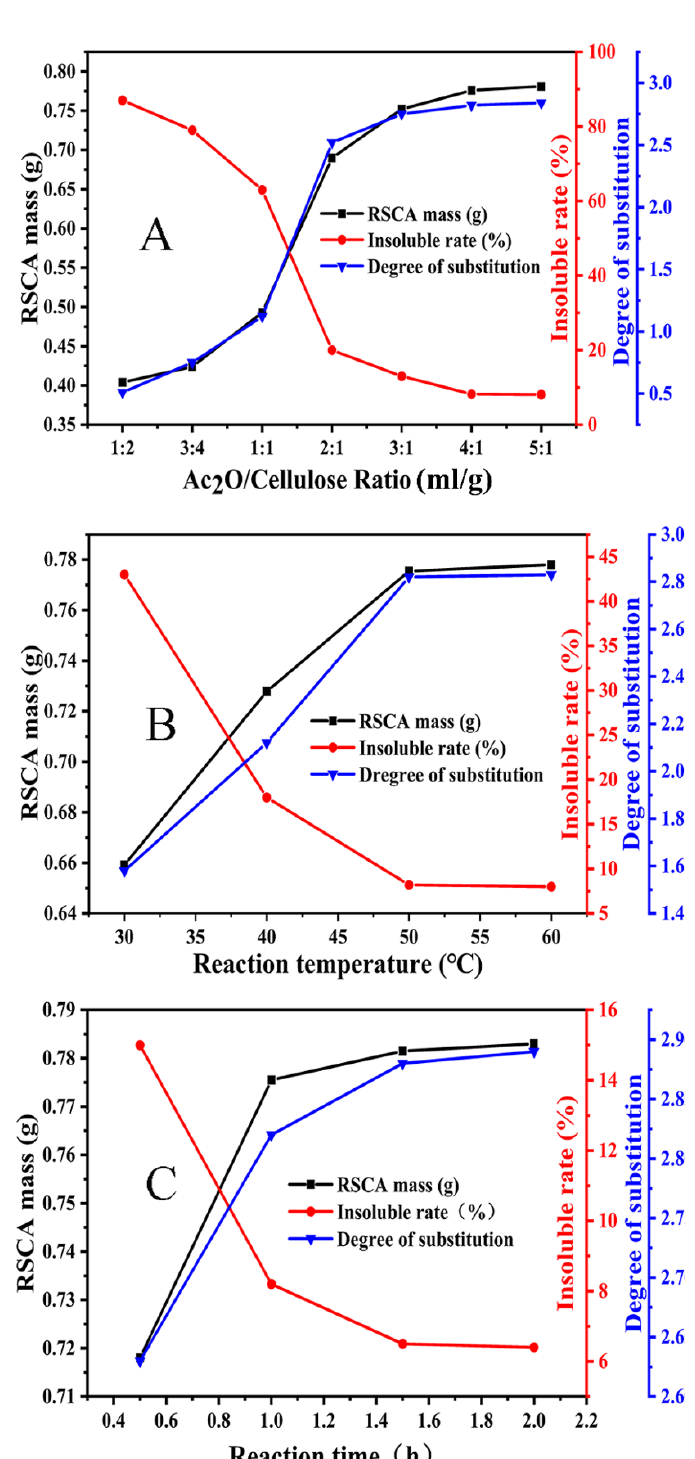
Figure 4. Optimization of the preparation conditions of RSCA: ( A ) Ac 2 O/cellulose ratio, ( B ) reaction temperature, ( C ) reaction time.